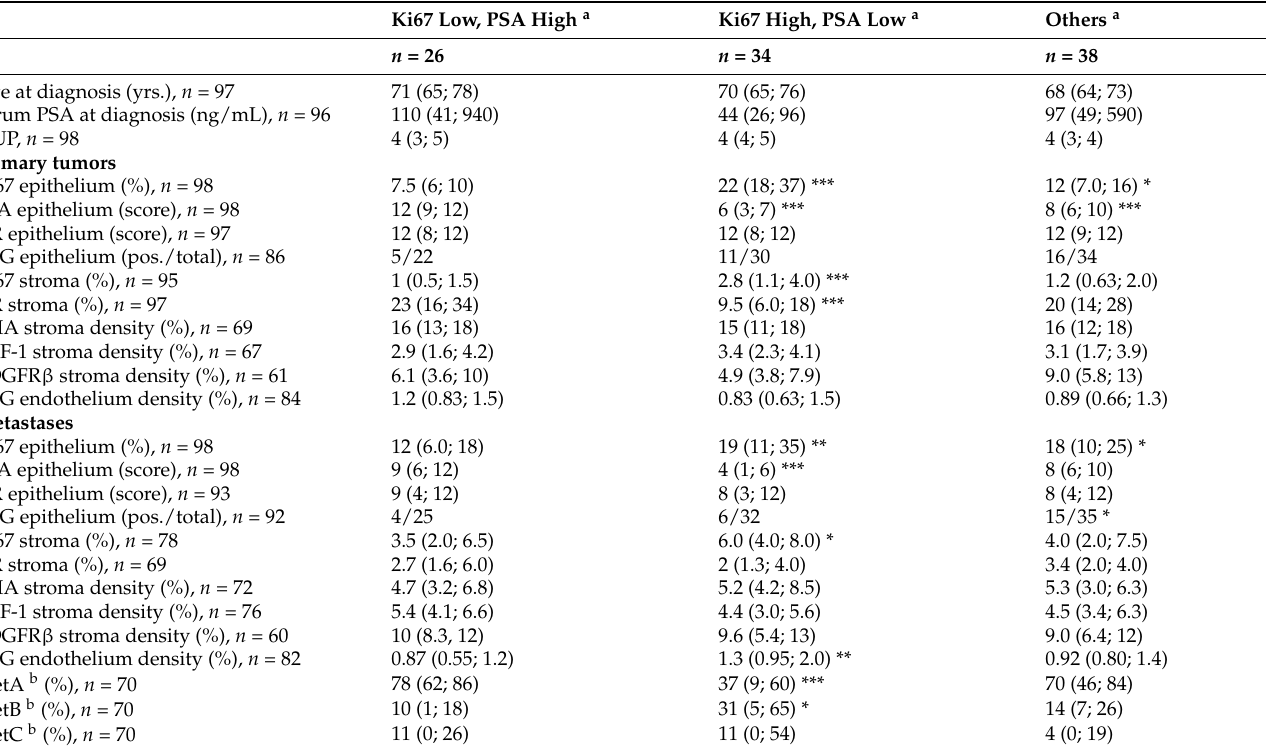
Table 4. Primary tumors differentiated based on combined immunostaining of the marker for proliferation Ki67 and prostate specific antigen (PSA), in relation to clinical variables, epithelial and stromal markers, and the transcriptomic metastasis subtypes MetA-C.